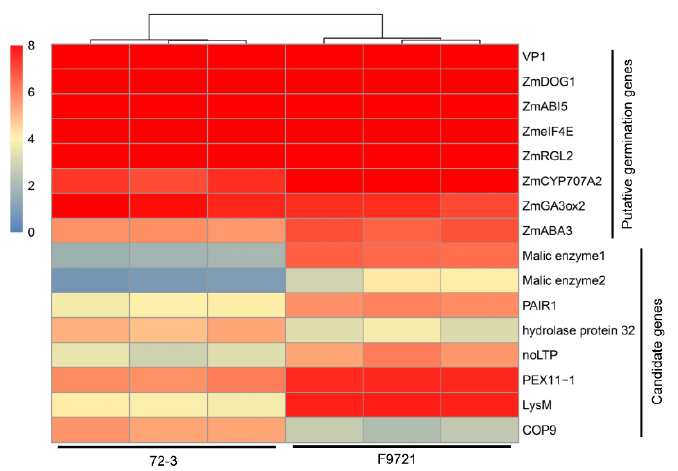
Figure 5. Gene expression of putative germination genes and GWAS candidate genes. Putative germination genes indicate those involved in maize seed germination or maize homologs with germination genes of Arabidopsis. Candidate genes indicated DEGs located in the 2 Mb GWAS candidate locus.